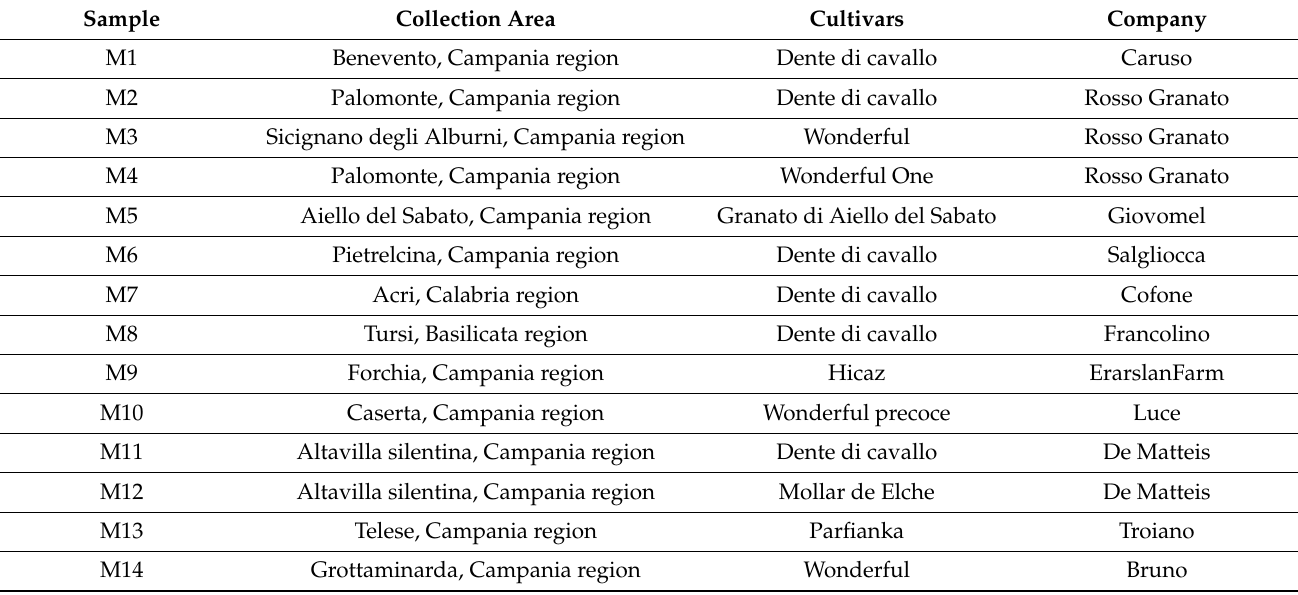
Table 1. Cultivars and collection area of the fourteen Punica granatum